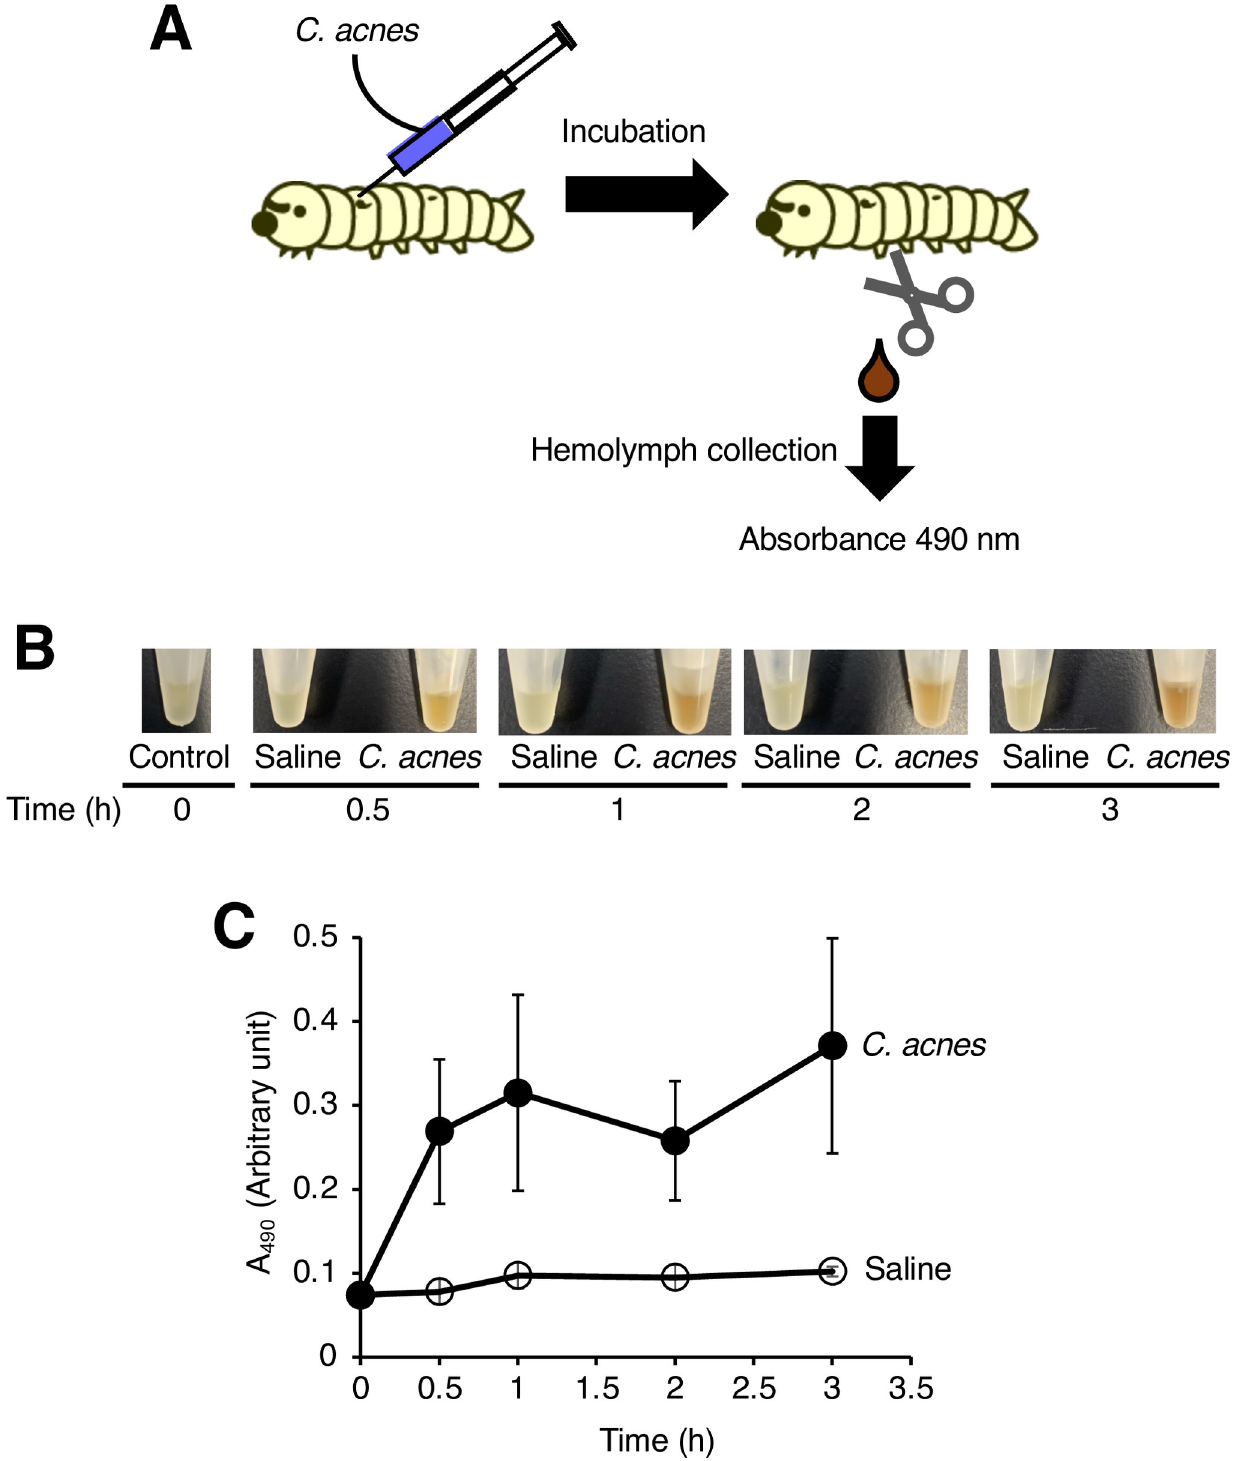
Fig 1. Induction of silkworm hemolymph melanization by injection of C . acnes . (A) Illustration of an experimental method to determine the silkworm hemolymph melanization. Silkworms were injected with saline (Saline) or C . acnes cell suspension ( C . acnes ; 1.1 x 10 7 cells/larva), and reared at 37˚C. Silkworm hemolymph was collected for 3 h, photographs of the silkworm hemolymph were taken (B), and absorbance at 490 nm (A 490 ) (C) was measured. The arbitrary unit was defined as the absorbance at 490 nm of a sample of silkworm hemolymph (50 μ l) mixed with saline (50 μ l).